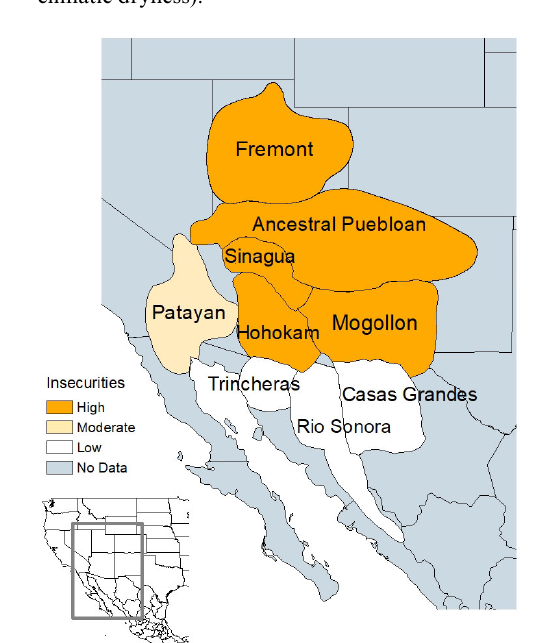
Fig. 7 . Community insecurity prior to depopulation (indicator: increasing